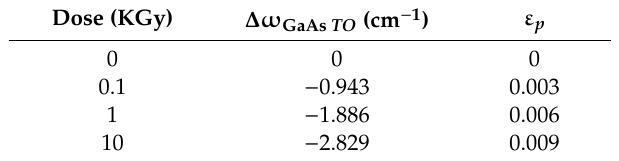
Table 4. The phonon frequency shift ( ∆ ω TO ) and the strain ( ε p ) for Si-doped GaAs under 0, 0.1, 1 and 10 KGy γ -radiation.